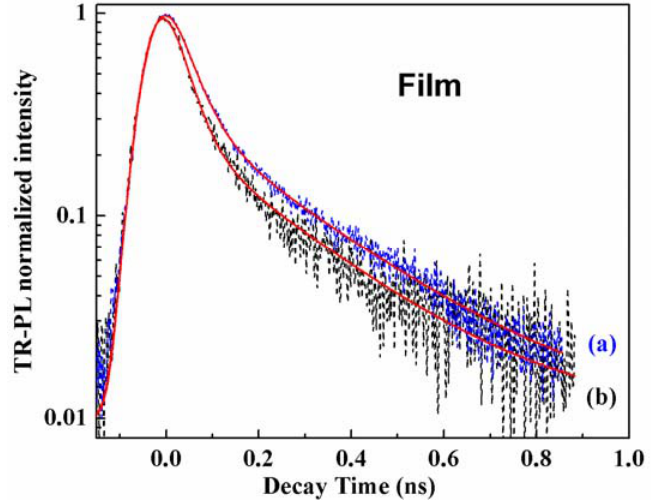
Figure 12. Integrated TR-PL decays of (a) OMPA and (b) OBMPA in solid state thin